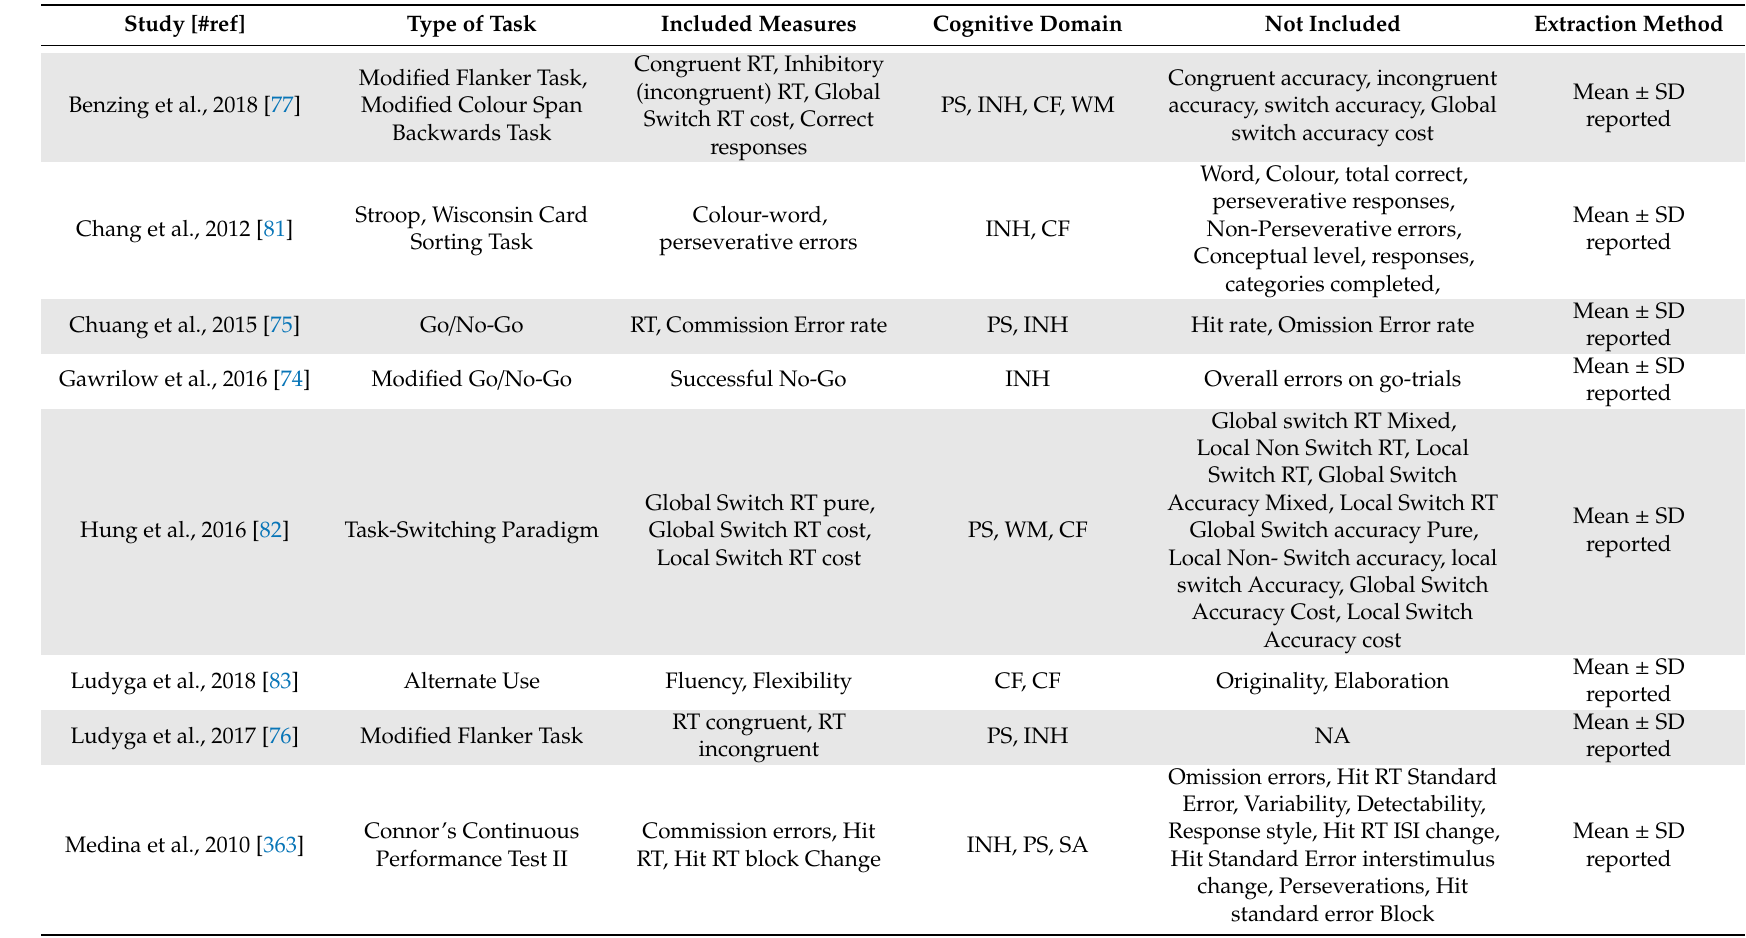
Table A1. Included and excluded dependent variables from acute